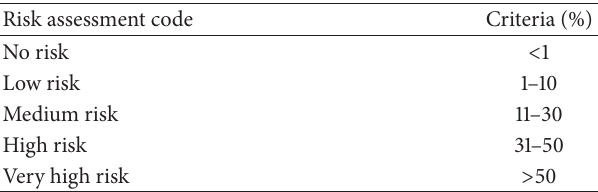
Table 1: The 𝐸 𝑖 𝑟 and 𝑅 𝐼 values of the heavy metals. Sampling